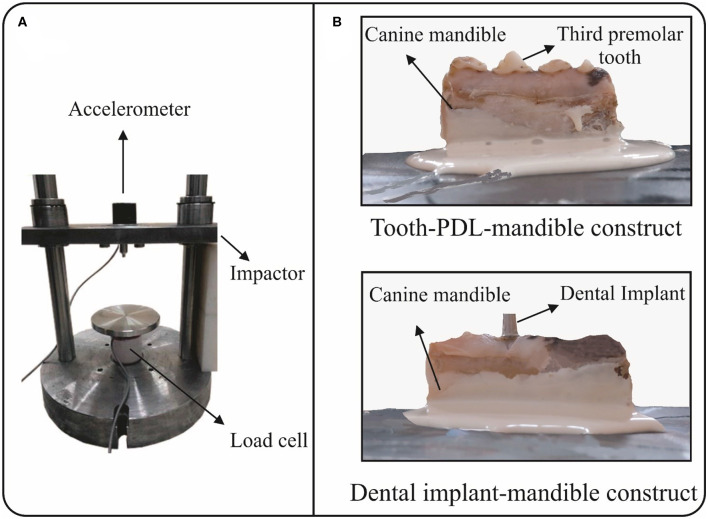
In-vitro experimental set-up: (A) A custom-made drop tower apparatus used to mimic impact loading, which contains three main parts: an accelerometer, a load cell, and a flat and smooth impactor; and (B) Fixing the inferior surface of the specimens, i.e., tooth-PDL-mandible and dental implant-mandible constructs, by stone adhesive and Mitreapel BK-1002 adhesive on steel plates.